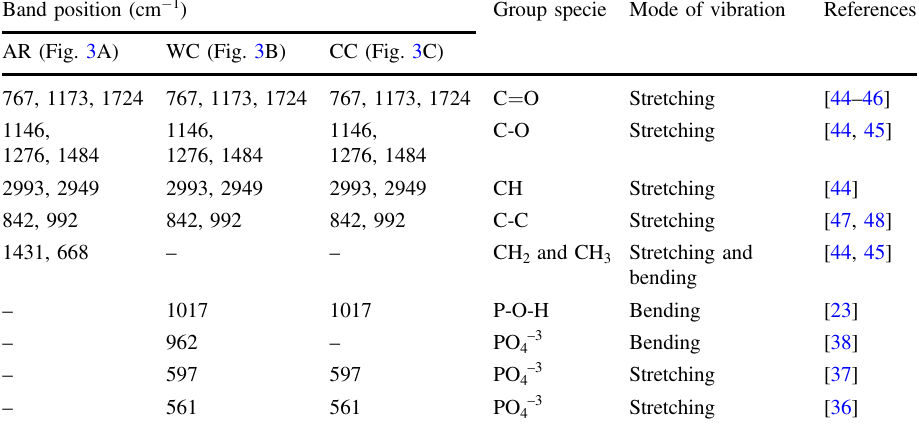
Table 1 Wavenumber position and IR absorption of different chemical groups on solid surfaces shown in Fig.